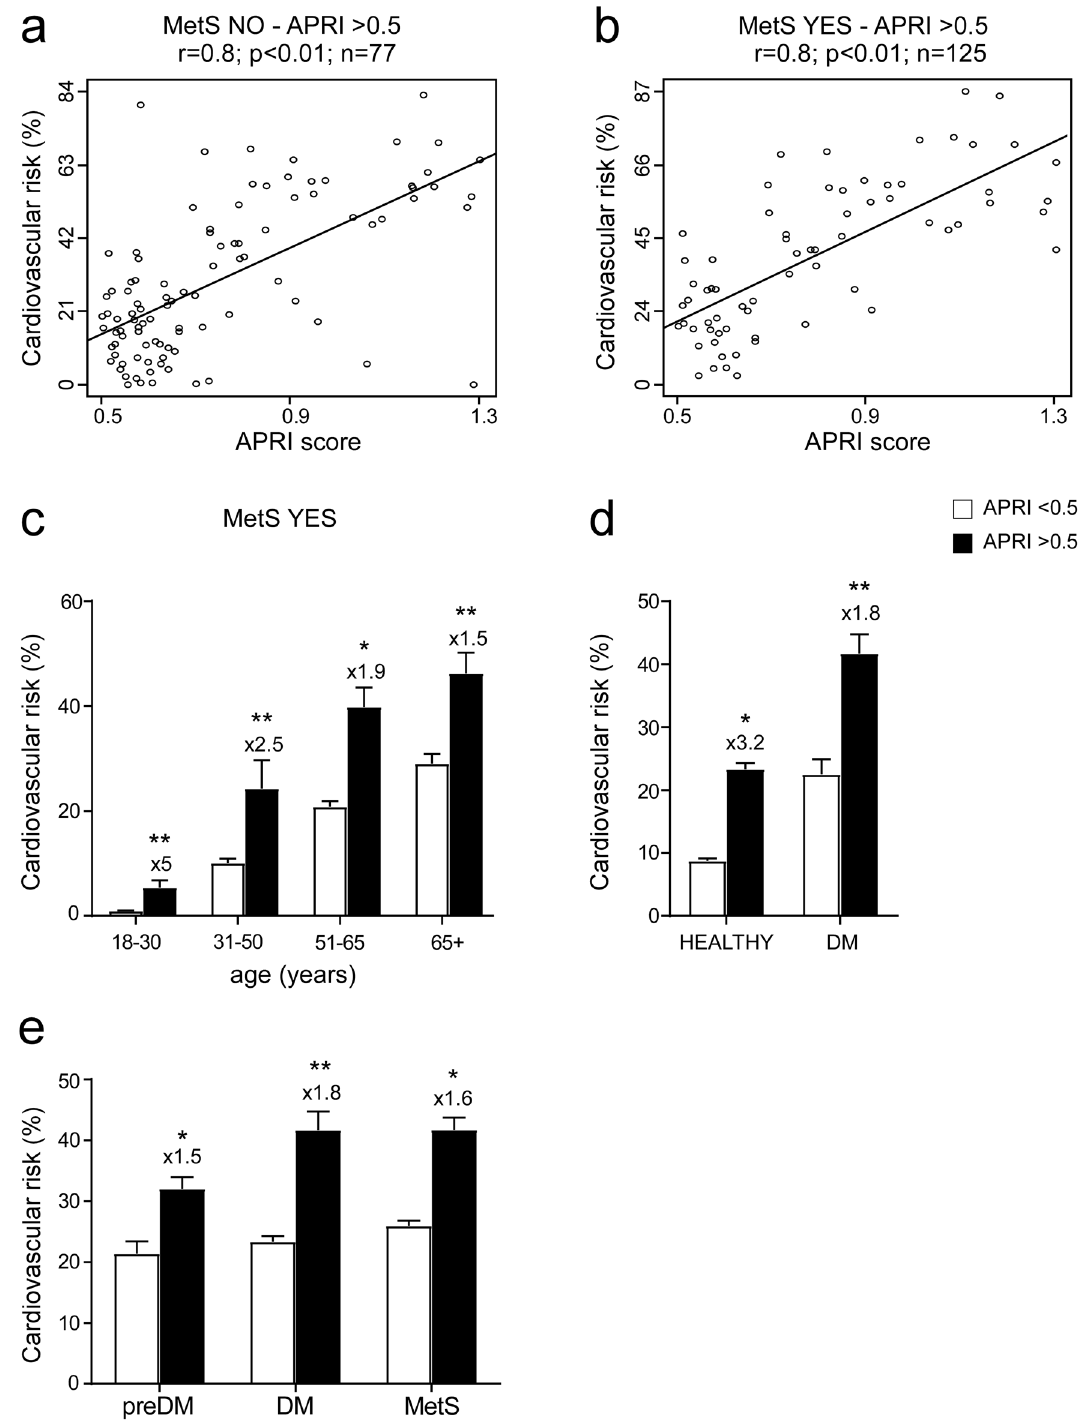
Figure 4. Correlation between APRI > 0.5 and cardiovascular risk in non-metabolic and metabolic subjects, classification by age and comparison in prediabetes and Diabetes Mellitus subjects. ( a , b ) Correlation analysis of APRI and cardiovascular risk (CVR) in non-metabolical (MetS NO) and MetS (MetS YES) subjects with APRI > 0.5. ( c ) Classification of MetS subjects in age ranges; subjects were divided by APRI levels with a cut-off of 0.5 to identify elevated APRI. Data is presented as mean ± SEM. Statistical significance was assessed by Student T-test (**p < 0.01). Multipliers are shown to identify difference in CVR in subjects with APRI > 0.5 compared to subjects with APRI < 0.5 of the same age. ( d ) Comparison of CVR in healthy and Diabetes Mellitus (DM) subjects divided by APRI levels. Data is presented as mean ± SEM. Statistical significance was assessed by Student T-test (*p < 0.05, **p < 0.01). Multipliers are shown to identify difference in CVR in subjects with APRI > 0.5 compared to subjects with APRI < 0.5 of the same age. ( e ) Comparison of CVR in PreDiabetes (preDM), Diabetes Mellitus (DM) and Metabolic (MetS) subjects divided by APRI levels. Data is presented as mean ± SEM. Statistical significance was assessed by Student T-test (*p < 0.05, **p < 0.01). Multipliers are shown to identify difference in CVR in subjects with APRI > 0.5 compared to subjects with APRI < 0.5 of the same